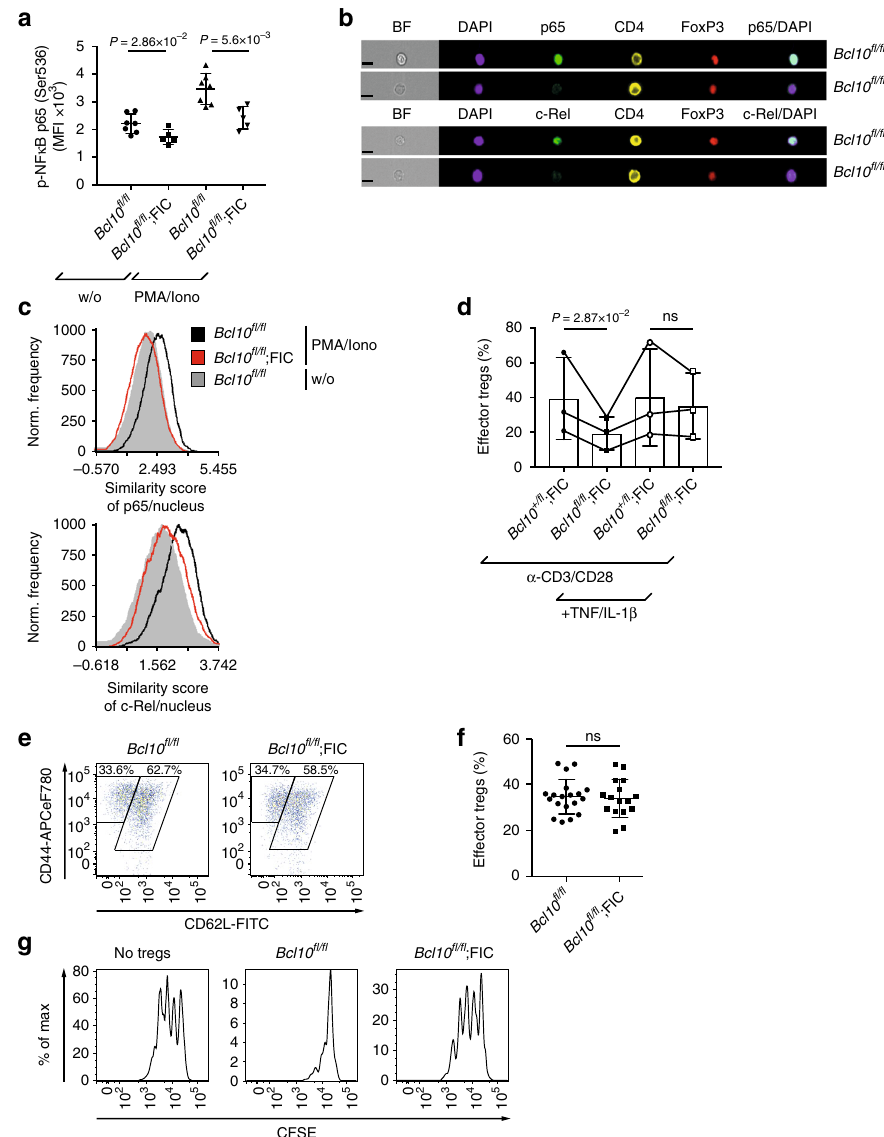
Fig. 3 In fl ammatory signals promote effector regulatory T cell (eTreg) conversion but not suppression. a PhosFlow to detect the median fl uorescence intensity (MFI) of phospho-nuclear factor- κ B (p-NF- κ B) p65 at serine 536 in viable CD4 + Foxp3 + splenic Tregs of 16-day-old male Bcl10 fl / fl and Bcl10 fl / fl ;FIC mice without (w/o) or with phorbol myristate acetate (PMA)/ionomycin. b Image stream analysis to detect the nuclear translocation of the NF- κ B subunits p65 (upper two images) and c-Rel (lower two images) in CD4 + Foxp3 + -gated splenic Tregs of 16-day-old male Bcl10 fl / fl or Bcl10 fl / fl ;FIC mice upon PMA/ionomycin. 4 ′ ,6-Diamidino-2-phenylindole (DAPI) was used as a nuclear stain. Black bars represent 10 μ m. (BF) bright fi eld. c Histogram pro fi les of the similarity scores of p65 (upper panel) or c-Rel (lower panel) and the DAPI stain. Black ( Bcl10 fl / fl ) and red ( Bcl10 fl / fl ;FIC) histograms represent the similarity score in splenic CD4 + Foxp3 + Tregs upon PMA/ionomycin. The gray histogram indicates unstimulated splenic CD4 + Foxp3 + Tregs ( Bcl10 fl / fl ). d Quanti fi ed analysis of the differentiation of sorted splenic CD4 + EYFP + CD62L hi rTregs of ≥ 2 pooled female Bcl10 fl / fl ; Rosa26 LSL-EYFP ;FIC and Bcl10 + / fl ; Rosa26 LSL-EYFP ;FIC mice into CD4 + EYFP + CD44 hi CD62L lo eTregs in the absence or presence of tumor necrosis factor (TNF (20 ng mL − 1 ) and interleukin-1 β (IL-1 β ) (20 ng mL − 1 ) and anti-CD3/CD28. Statistical signi fi cance was assessed by a ratio-paired t test; paired data points of one experiment are connected by a line. Data are cumulative of three independent experiments and illustrate three points without cytokines of Fig. 2e again; (ns) not signi fi cant. e Fluorescence-activated cell sorting (FACS) pro fi le detecting splenic CD62L hi rTregs and CD44 hi CD62L lo eTregs in the viable CD4 + Foxp3 + cell gate of 16- day-old male Bcl10 fl / fl and Bcl10 fl / fl ;FIC mice. f Frequencies of splenic CD44 hi CD62L lo eTregs in the viable CD4 + Foxp3 + cell gate of 16-day-old male Bcl10 fl / fl or Bcl10 fl / fl ;FIC mice. g In vitro Treg-suppressor assay: carboxy fl uorescein succinimidyl ester (CFSE)-labeled naive conventional CD4 + T cells were cultivated at a 2:1 ratio without Tregs (left plot), with sorted CD4 + CD25 + CD45RB lo Tregs of 16-day-old male Bcl10 fl / fl (middle plot) or Bcl10 fl / fl ;FIC (right plot) mice in the presence of irradiated splenocytes and anti-CD3. FACS plots are representative of fi ve independent experiments and show the proliferation of viable CFSE + -gated cells. Statistical signi fi cances in a and f were calculated by a two-tailed unpaired Student ’ s t test. Bars in a , d , and f represent the mean ± SD. Data are representative of b , c two or e eight independent experiments and cumulative from a two or f eight independent experiments. Source data are provided as a Source Data